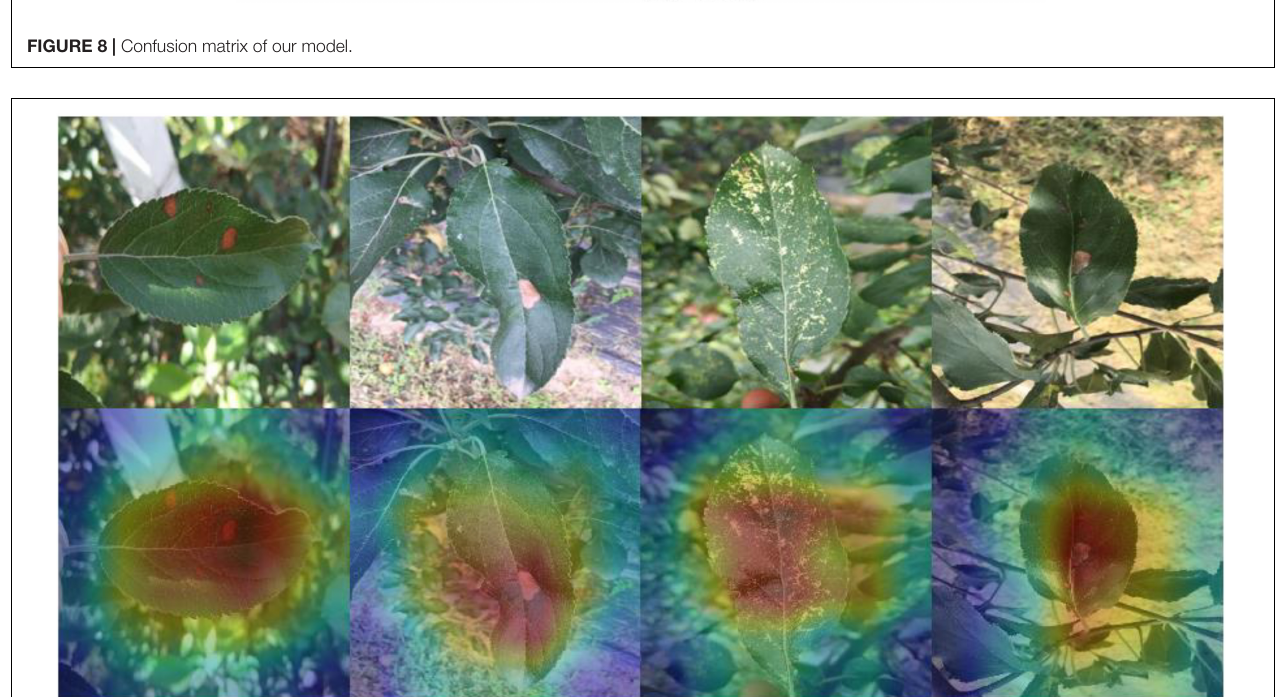
FIGURE 9 | Heat map of our model: the disease area of apple leaves is shown with a certain